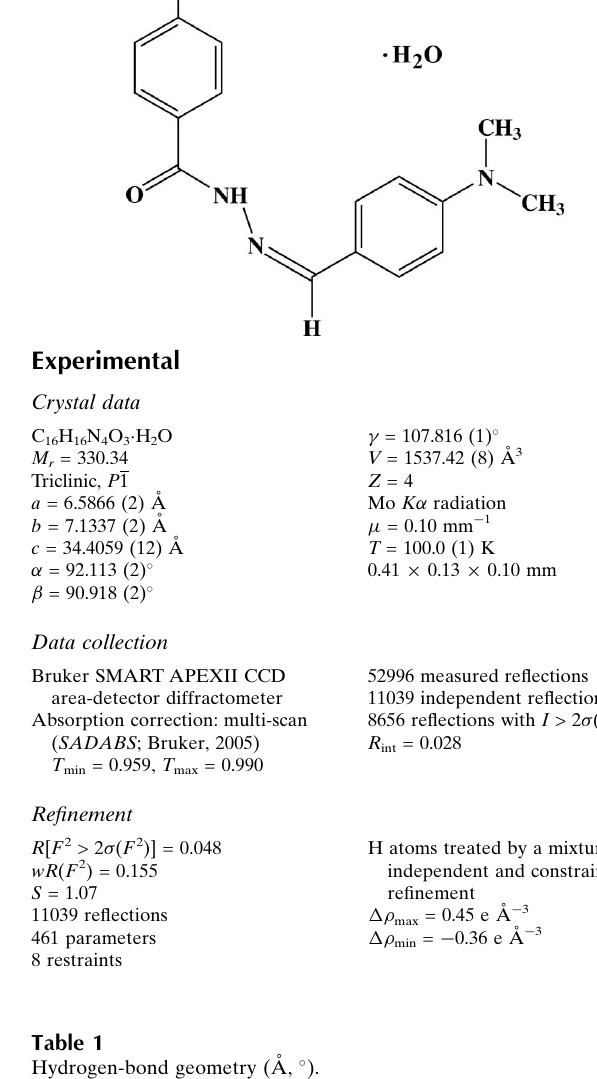
Hydrogen-bond geometry (A˚ , (cid:2) ). D —H (cid:1)(cid:1)(cid:1) A D —H H (cid:1)(cid:1)(cid:1)